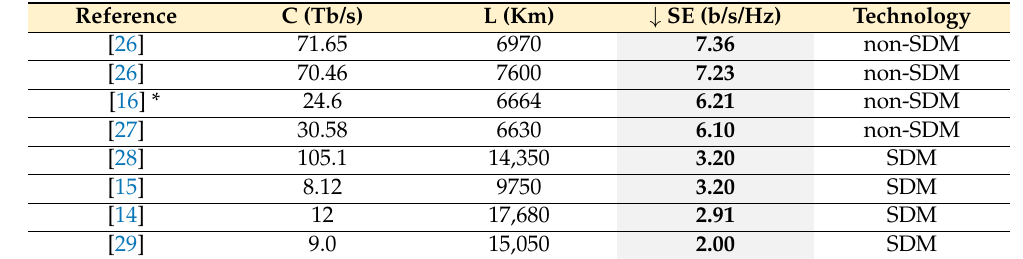
Table 6. Comparison of transmission experiments at transoceanic